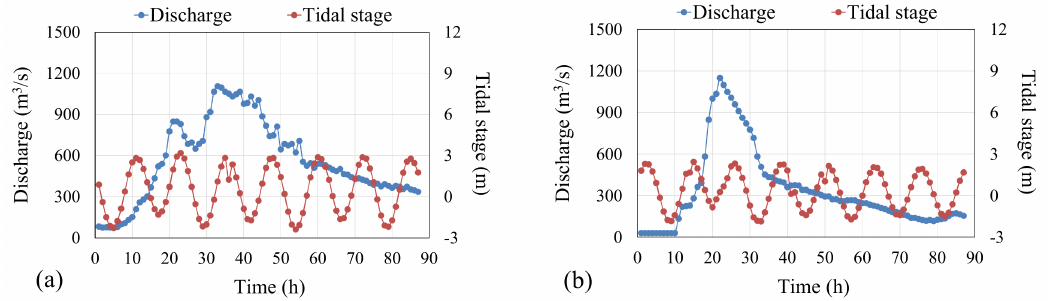
Figure 5. Boundary conditions for the test events of Typhoons ( a ) Saola and ( b ) Soulik.